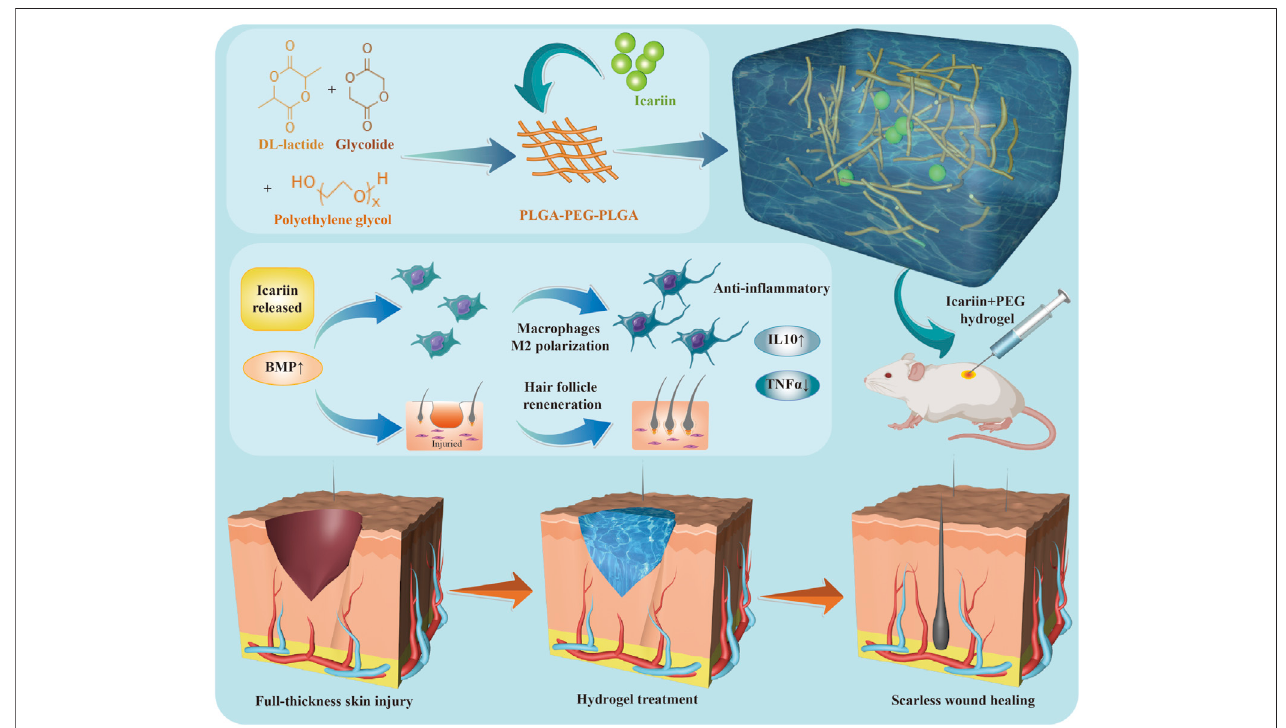
SCHEME 1 | Formation of icariin+PEG hydrogels and mechanism of wound